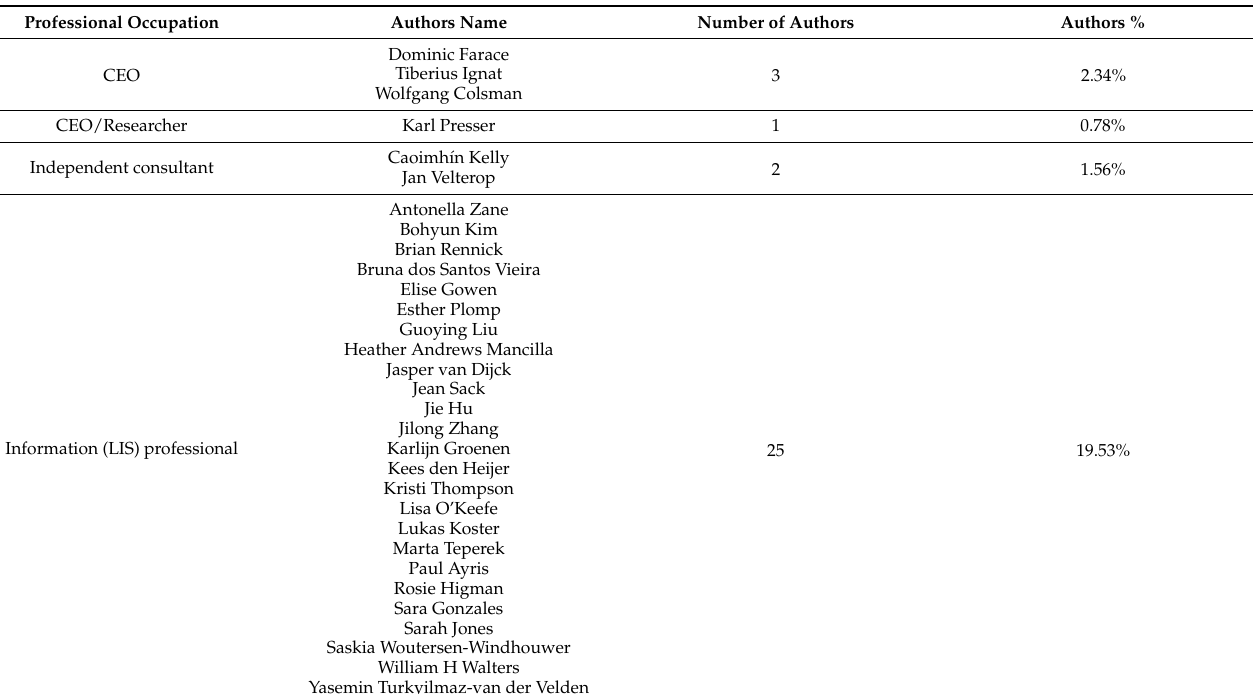
Table A3. Authors’ professional